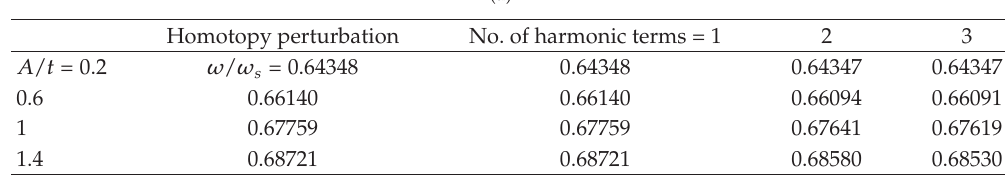
Table 1: (cid:3) a (cid:6) Harmonic term convergence for various amplitudes (cid:3) 1st resonant frequency (cid:6) . (cid:3) b (cid:6) Harmonic term convergence for various amplitudes (cid:3) 2nd resonant frequency (cid:6) .